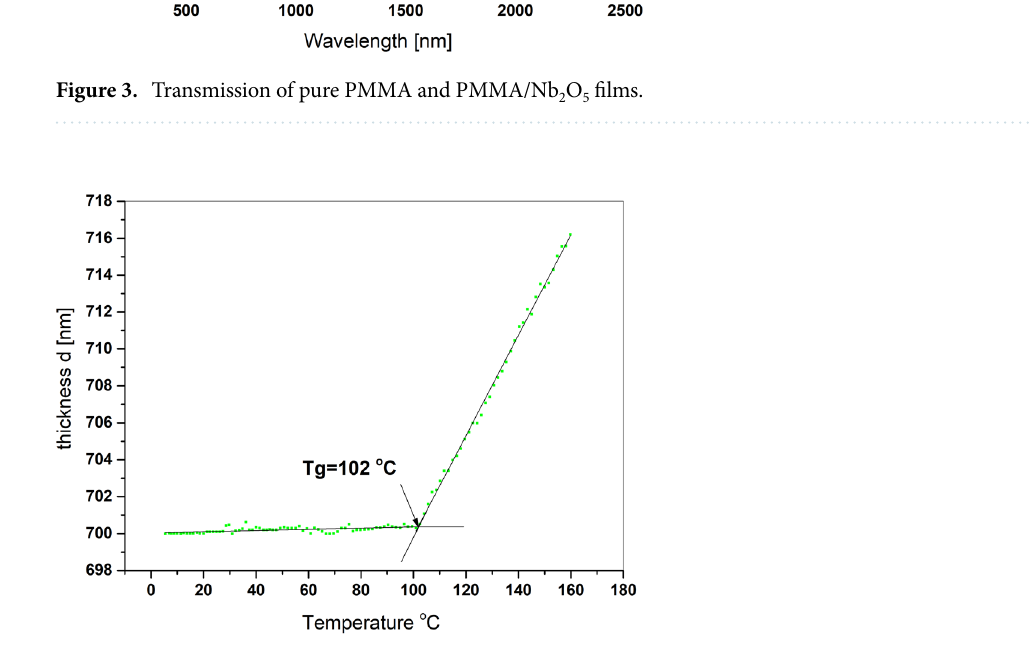
Figure 4. Thickness of pure PMMA as temperature